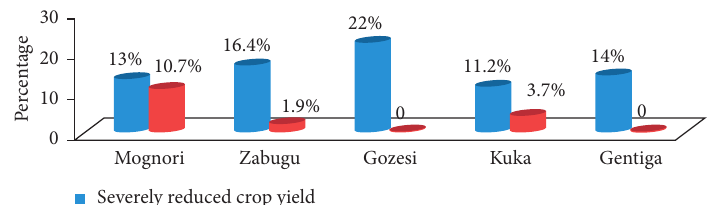
Figure 10: Respondents view on the effect of growing season on crop yield.